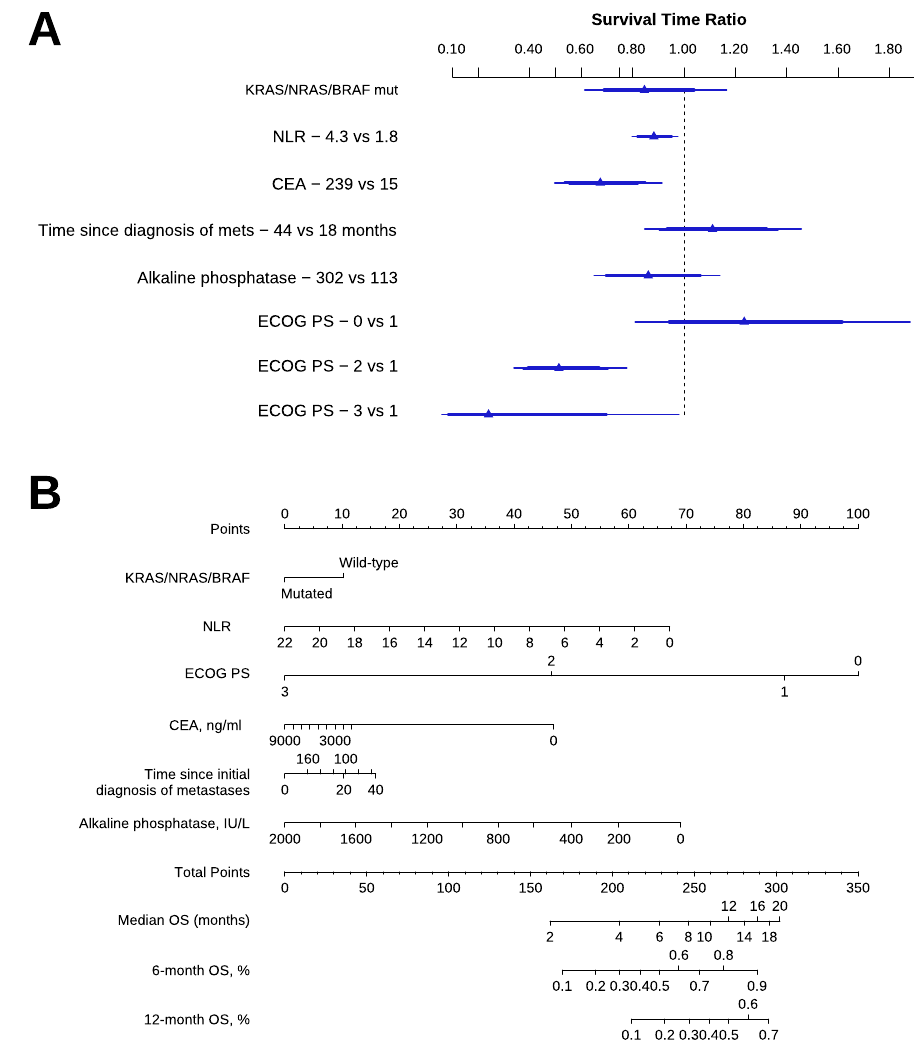
Figure 4. AFT lognormal model for overall survival ( A ), and nomogram ( B ). Abbreviations: AFT, accelerated failure time; NLR, Neutrophil-to-lymphocyte ratio; ECOG-PS, Eastern Cooperative Oncology Group Performance Status; OS, overall